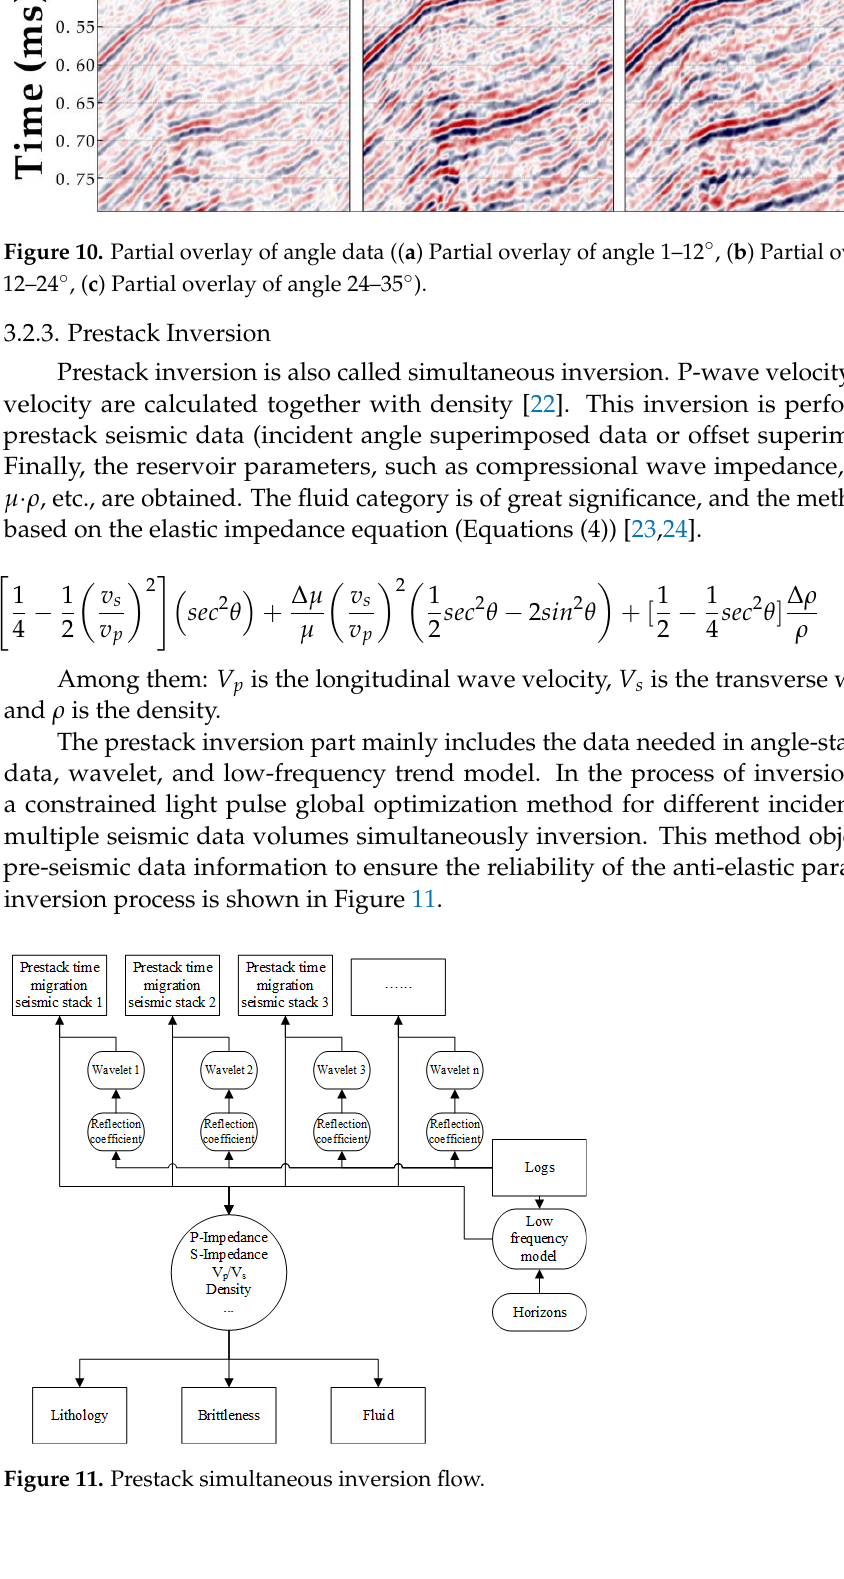
Figure 9. Comparison of 3D seismic tracking data before and after optimization process. ( a ) is the seismic profile before optimization. ( b ) is the optimized seismic profile.